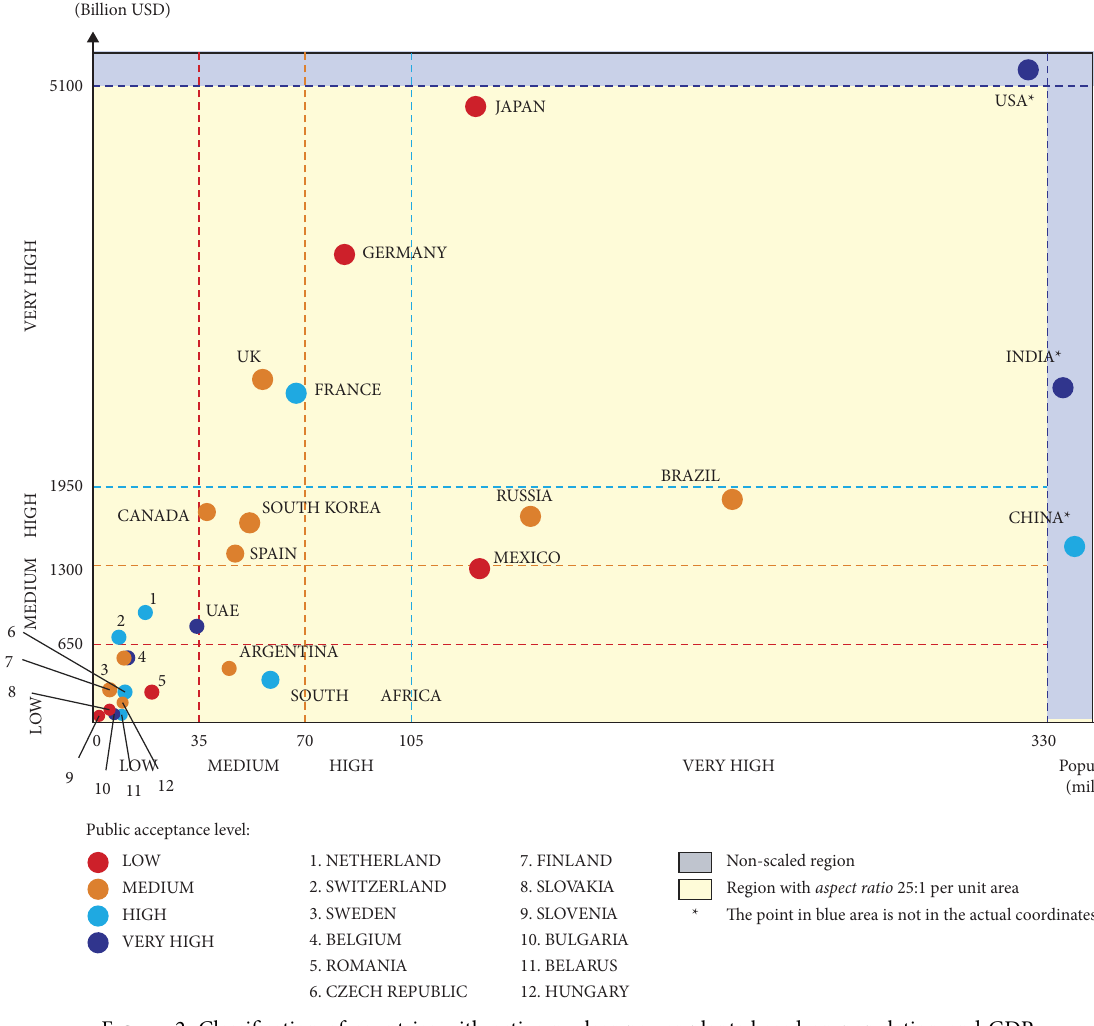
Figure 2: Classifcation of countries with active nuclear power plants based on population and